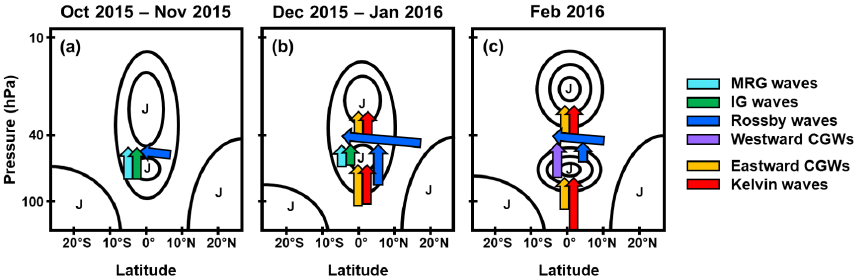
Figure 16. Schematic of the zonal wind evolution (black contour) and the anomalous wave forcing (arrow) during the QBO disruption